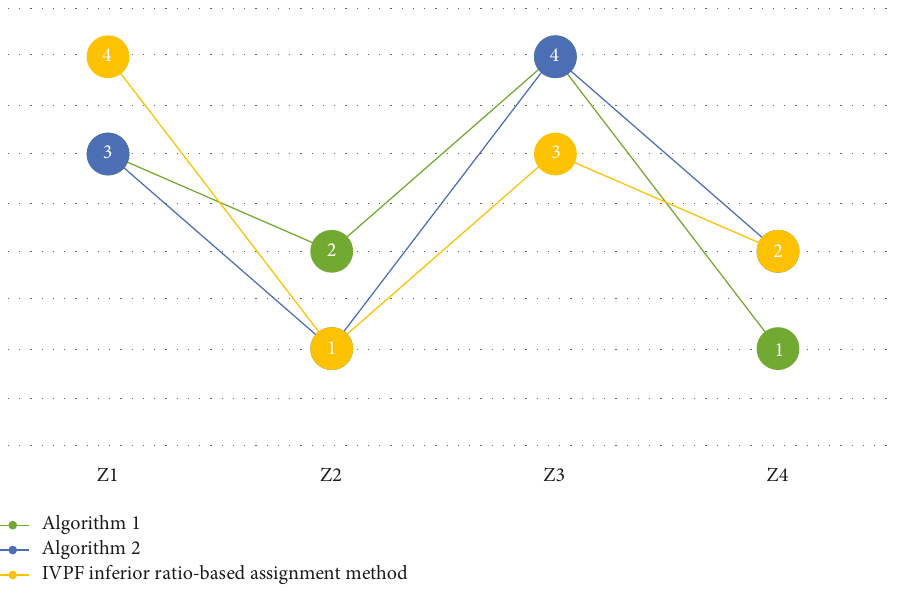
Figure 5: Contrast of ultimate priority rankings in the risk evaluation